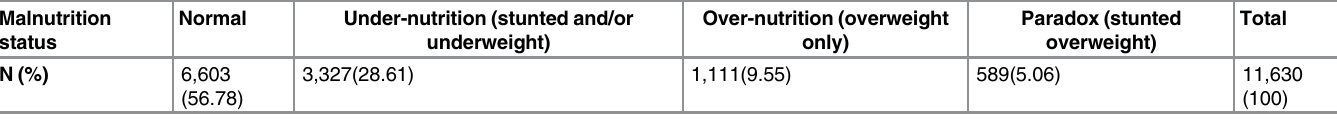
Table 2. Sample sizes and percentages of four exclusive malnutrition categories among children in rural China, the CHNS 1991 – 2009. Malnutrition status